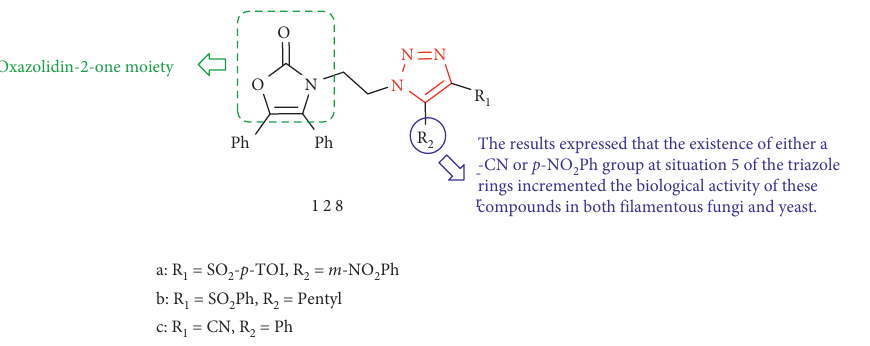
Figure 63: Chemical structure of oxazolidin-2-one-linked-1,2,3-triazoles.